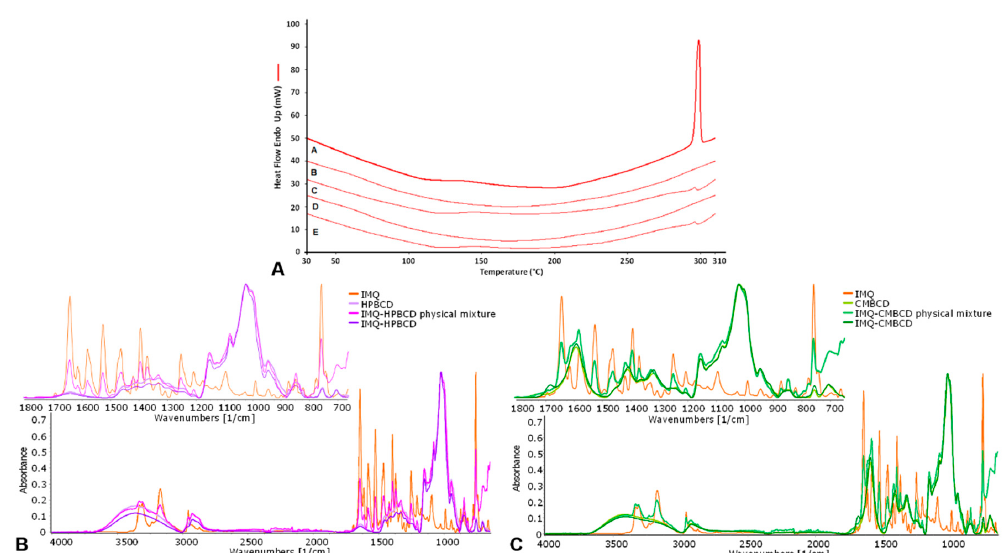
Figure 2. ( A ) Differential scanning calorimetry (DSC) thermograms of imiquimod (IMQ) and IMQ inclusion complexes: (A) IMQ, (B) IMQ–HP β CD, (C) IMQ–HP β CD physical mixture, (D) IMQ–CM β CD, (E) IMQ–CM β CD physical mixture; ( B ) Attenuated total reflection–Fourier